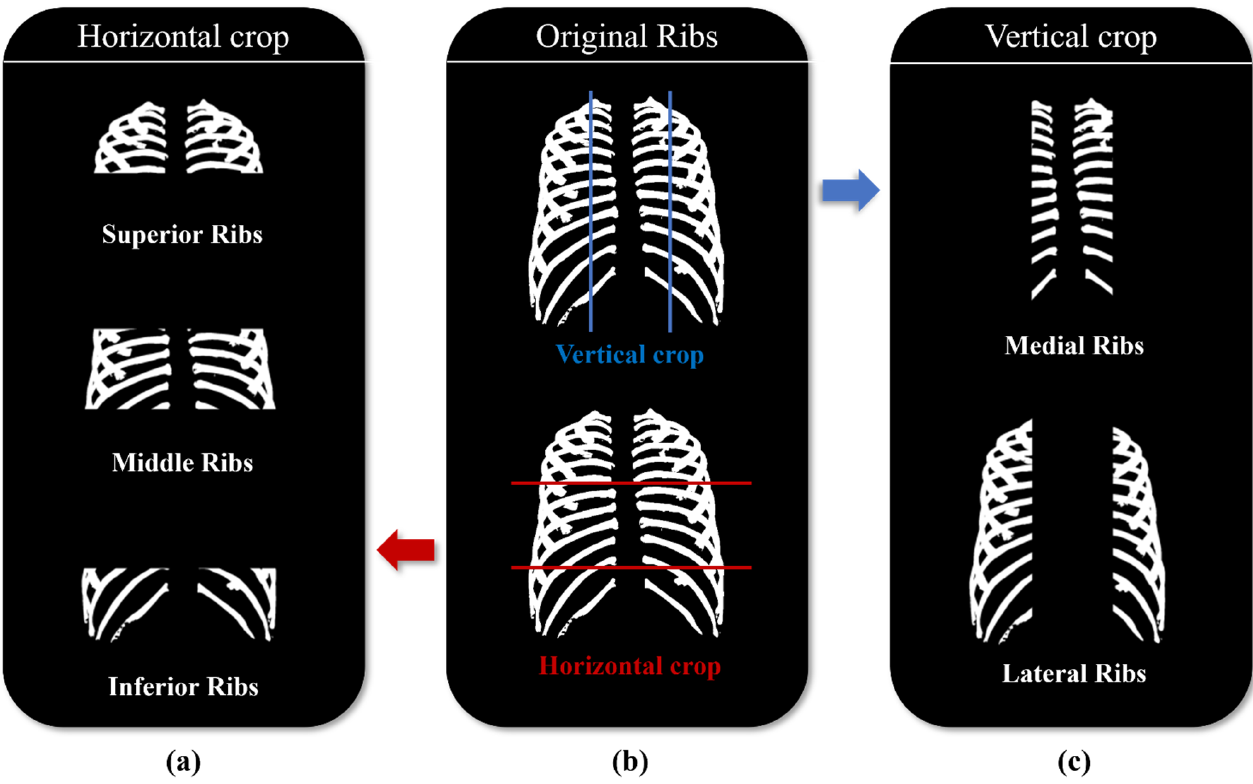
Figure 3. Criteria of dividing ribs: ( a ) Ribs vertically divide into medial and lateral of spine; ( b ) Original chest X-ray image; ( c ) Ribs horizontally divided into superior, middle, and inferior based on the clavicle, heart, and lower organs.